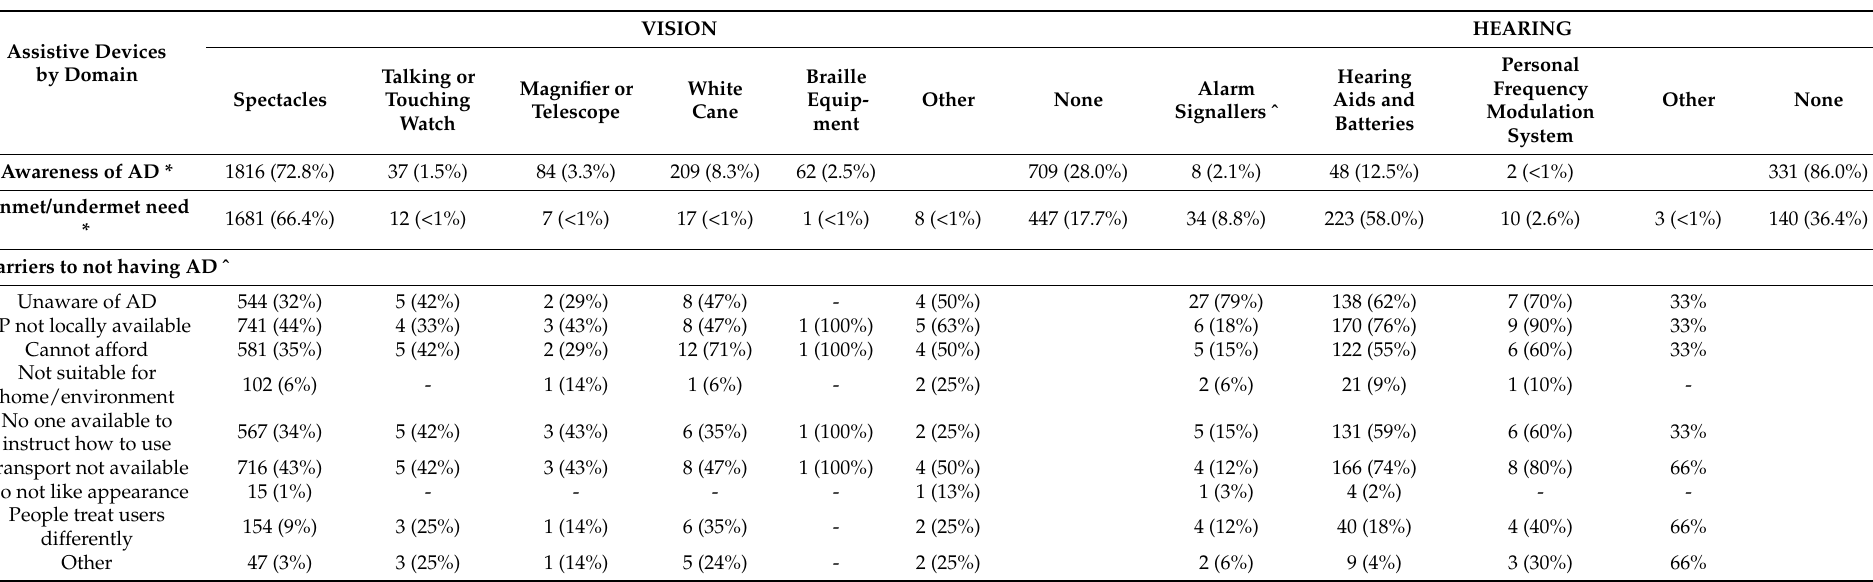
Table 4. Self-reported awareness, need and barriers to accessing vision and hearing assistive devices amongst participants who self-reported “some or worse” difficulty in vision and hearing,